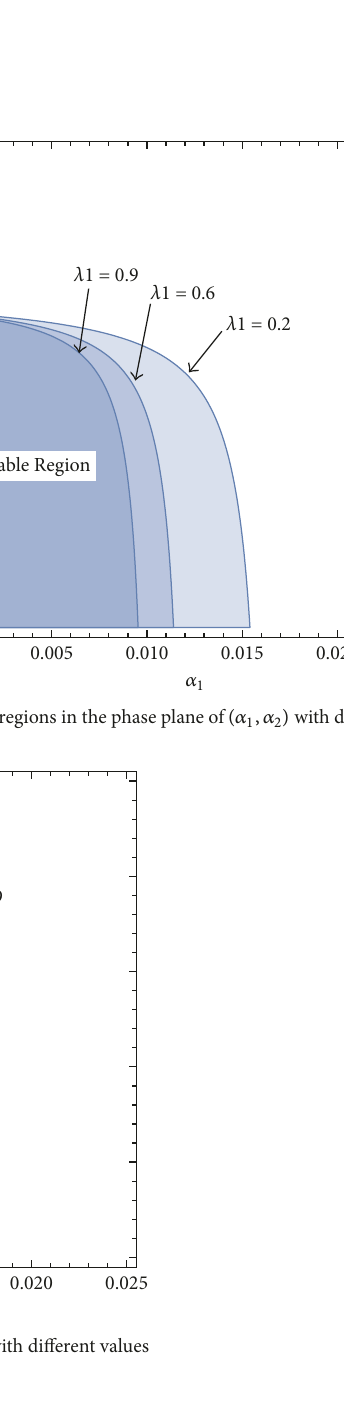
(c) The stability regions in the phase plane of (𝛼 1 ,𝛼 2 ) with different values of 𝜆